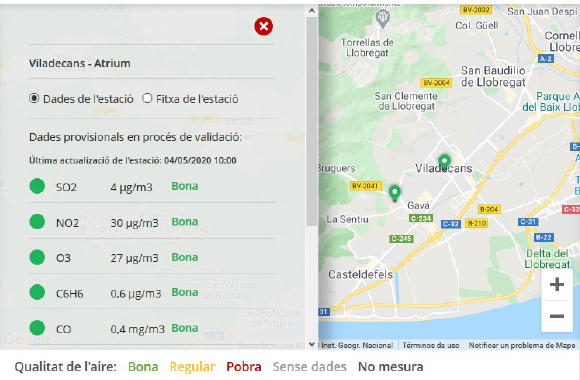
Figure 4. Viladecans reference station from DTES.